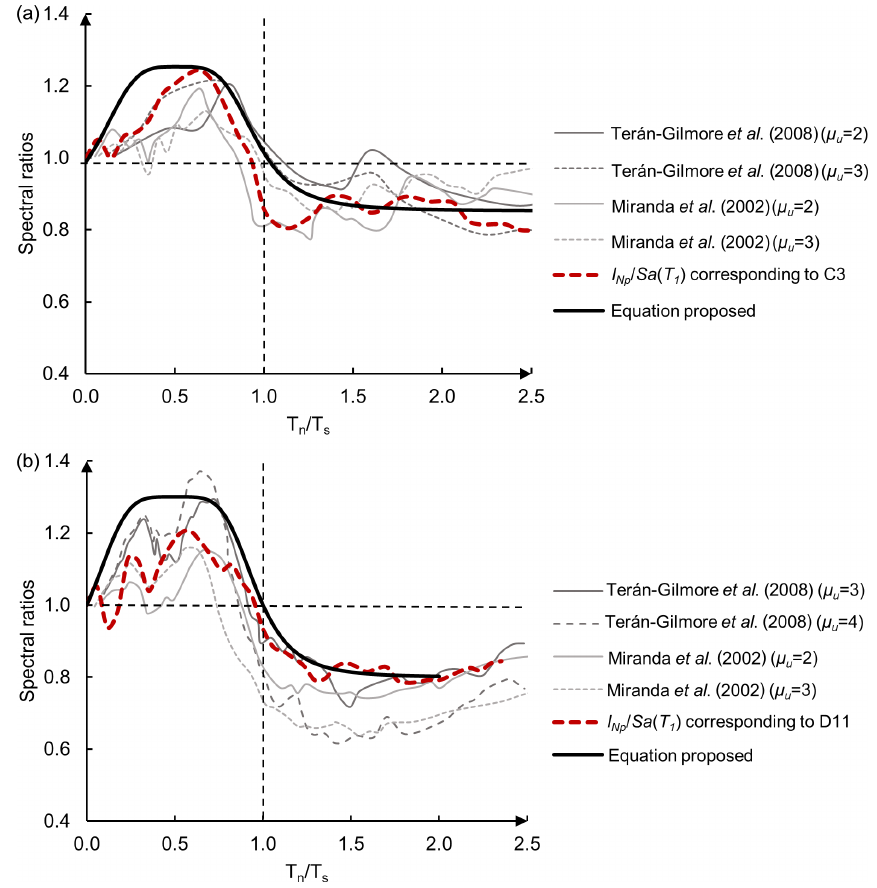
Figure 10. Mean ratios of strength demands of degrading and of non-degrading systems corresponding to (a) firm ground (zone C) and (b) soft soil (zone D) of Mexico